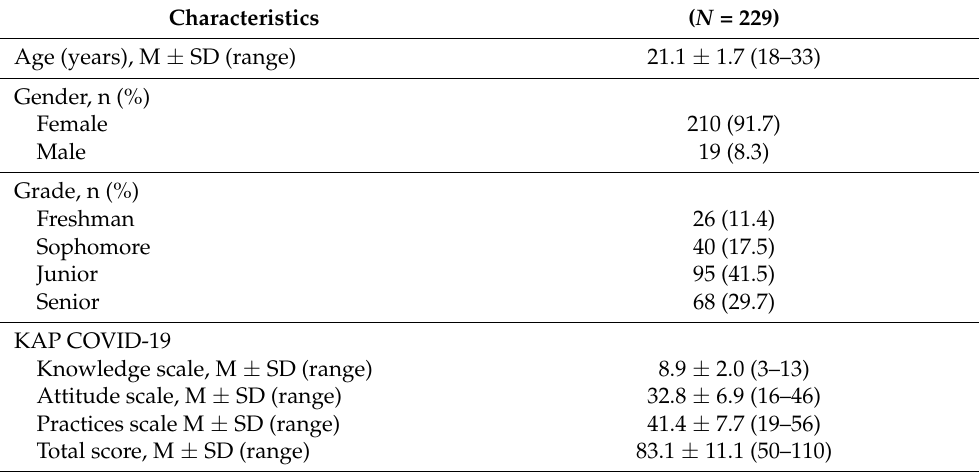
Table 1. Characteristics of study participants.